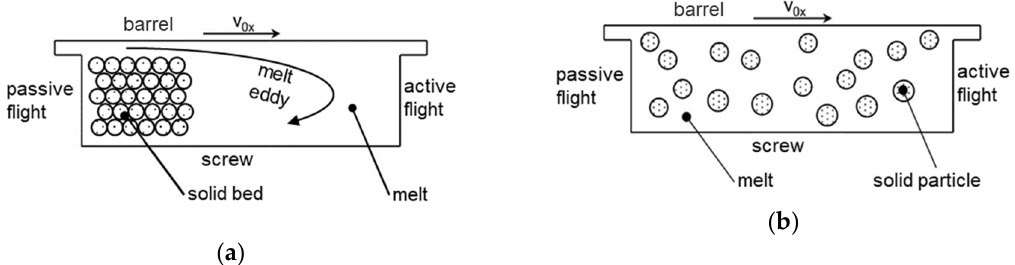
Figure 3. Schematic representation of the conventional ( a ) and disperse ( b ) melting models.